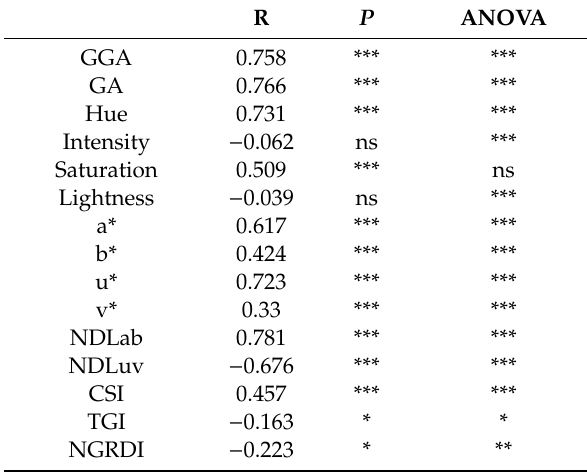
Table 4. Correlation coe ffi cients between the remote sensing UAV RGB VIs and ground RGB VIs. These indices are defined in Section 1 and further detailed in Section 2. Levels of significance: *, P <